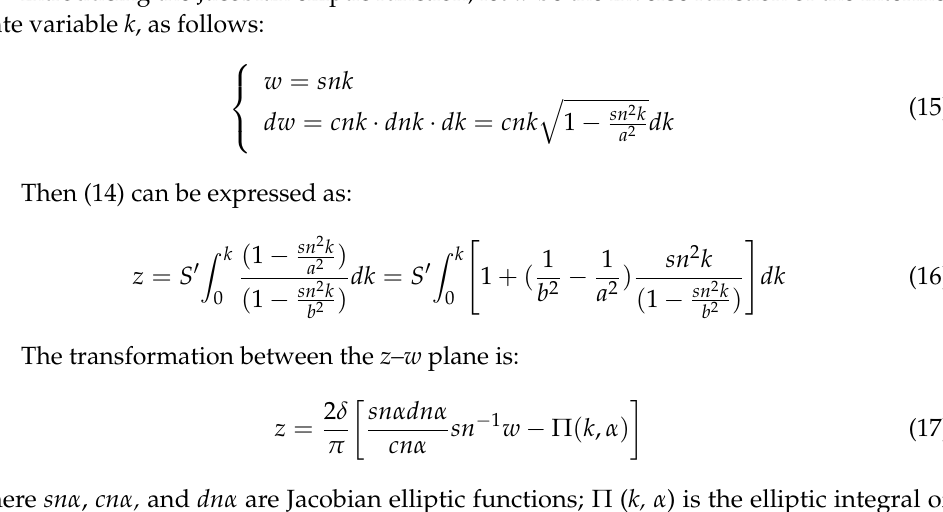
Table 1. SCT table of z plane and w plane of finite slot depth model. z Plane w Plane θ * Point Coordinate Point Coordinate z 1 − b s /2 + j ( h + δ ) π /2 w 1 − 1 z 2 − b s /2 + j δ 3 π /2 w 2 − a − ∞ + j 0 z 3 0 w 3 − b − ∞ + j δ + ∞ + j 0 z 4 0 w 4 b + ∞ + j δ z 5 b s /2 + j δ 3 π /2 w 5 a z 6 b s /2 + j(h + δ ) π /2 w 1